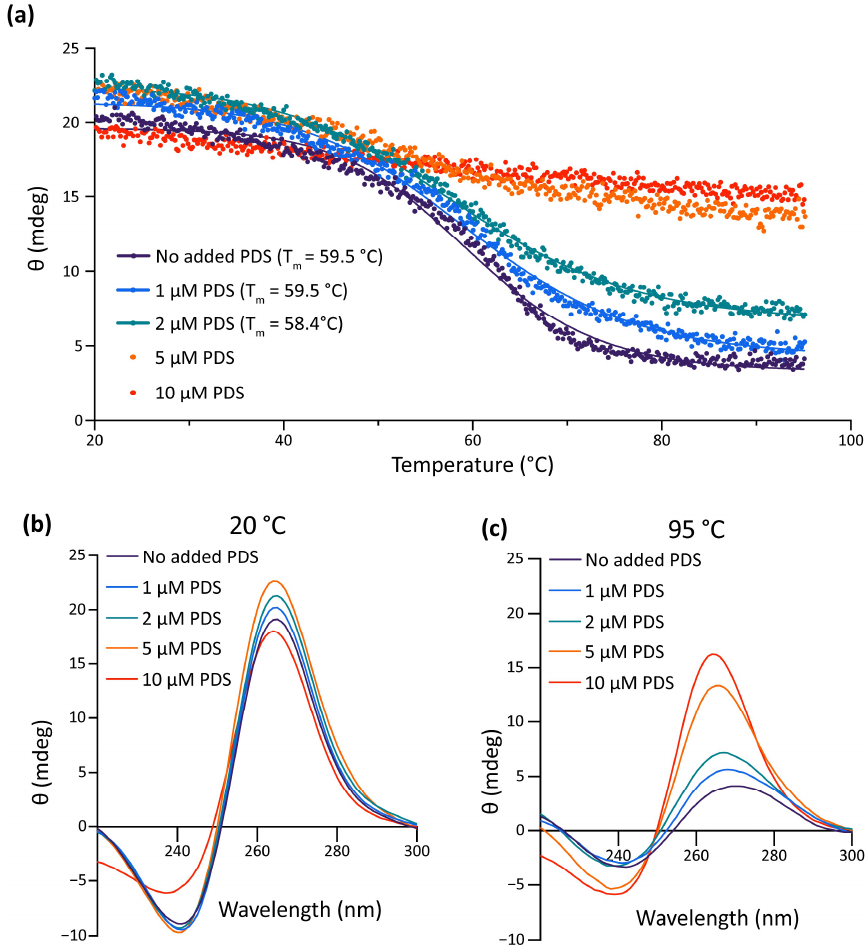
Figure 4. In vitro effect of PDS on pre-miR-150 G4 stability. ( a ) CD melting curves of the RNA oligonucleotide containing the pre-miR-150 PQS in presence of 1 mM K + and different PDS concentrations. The Tm for 5 and 10 µM PDS could not be calculated due to the absence of a clear melting transition. CD spectra of the RNA oligonucleotide containing the pre-miR-150 PQS folded in presence of 1 mM K + and incubated with different PDS concentrations at the start (( b ), 20 °C) and at the end (( c ), 95 °C) of the melting experiments.